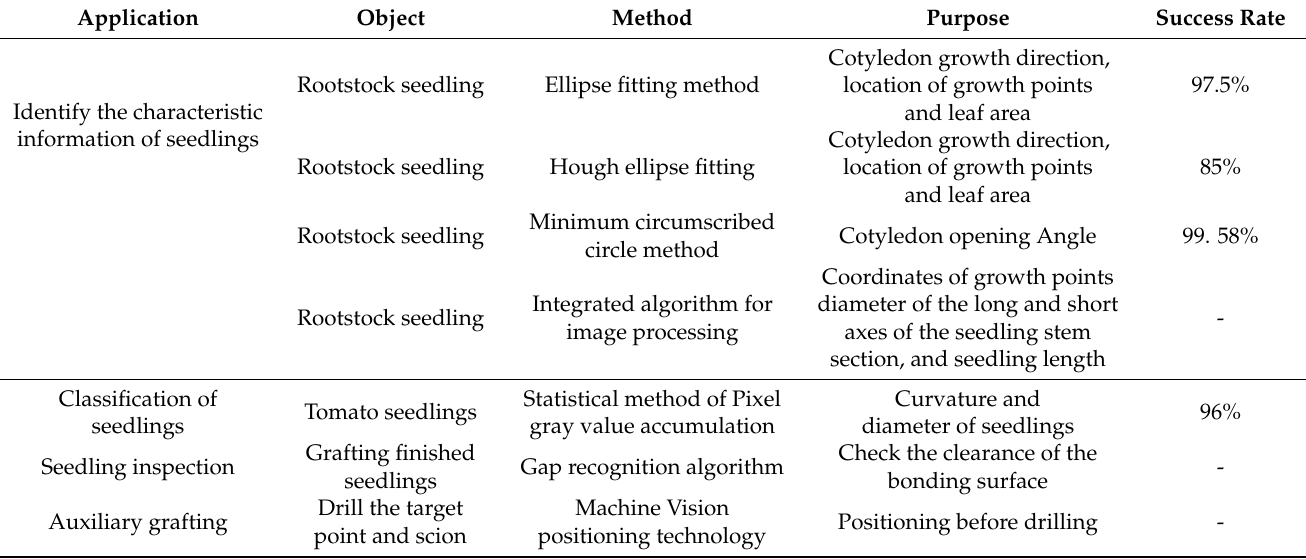
Table 6. Comparison of various applications of machine vision in